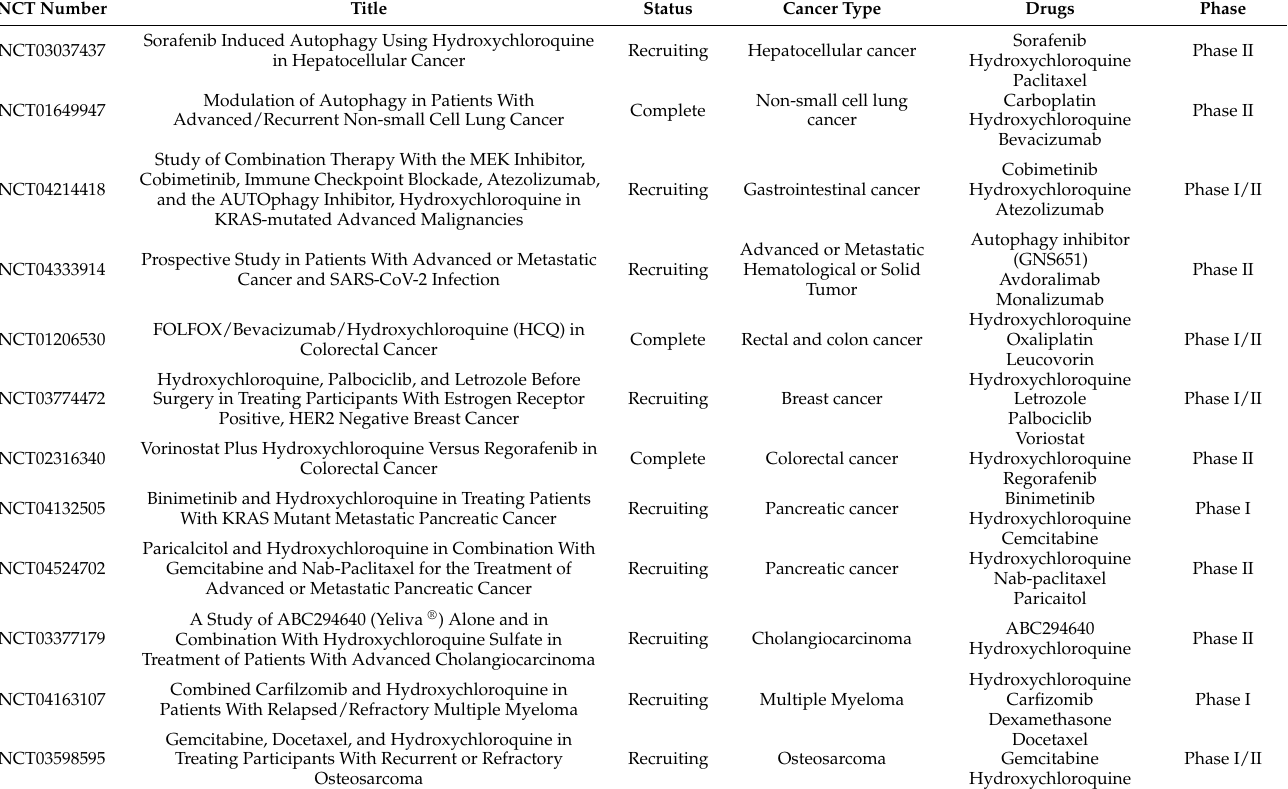
Table 3. Clinical trials using autophagy modulators in cancer